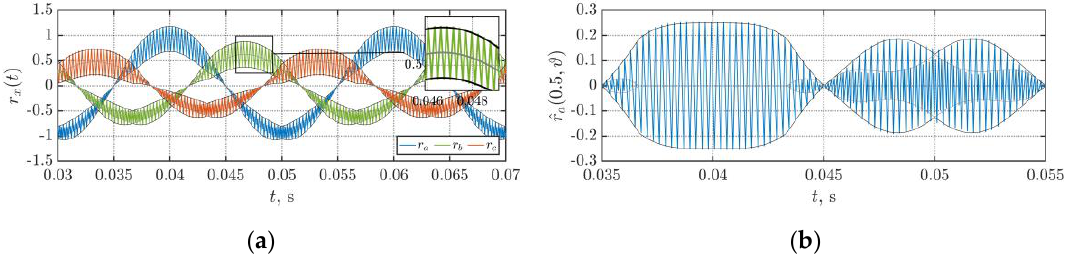
Figure 10. Primary (black) and secondary (gray) envelopes in case of DPWMMAX at m = 0.5 and f sw =